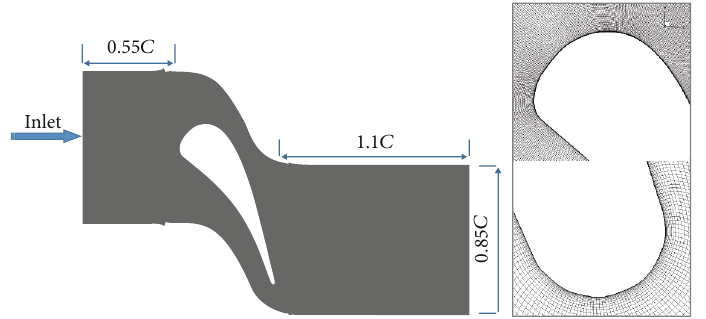
Figure 1: Computational domain and mesh details for VKI LS89.